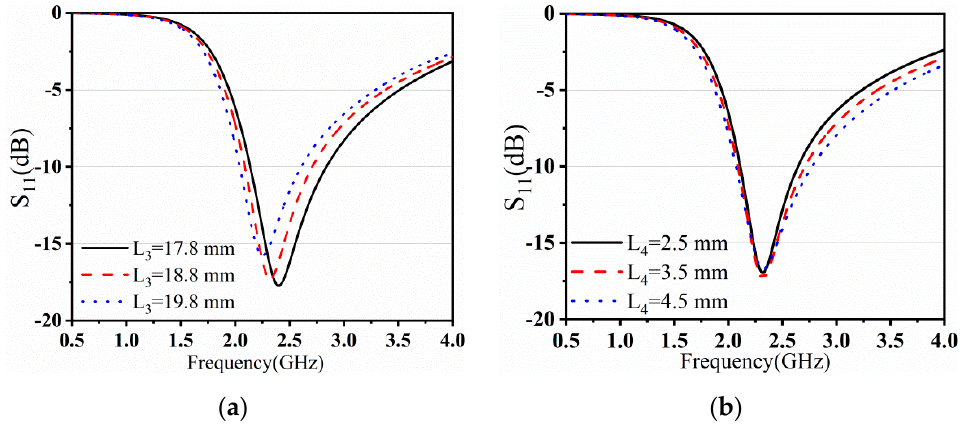
Figure 2. Simulated reflection coefficient varies with the parameters: ( a ) L 3 ; ( b ) L 4 .